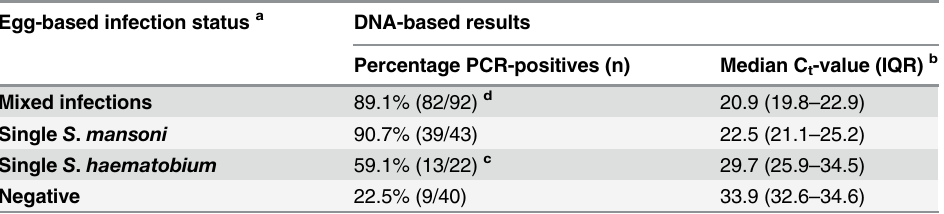
Table 3. PCR results according to Schistosoma infection status as assessed by microscopy in